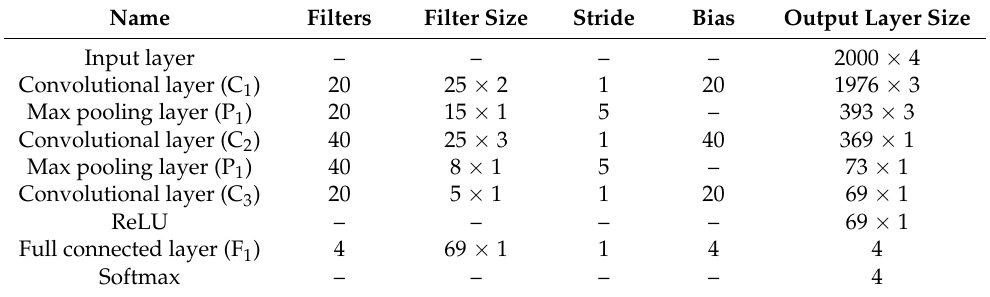
Table 5. Detail of the proposed